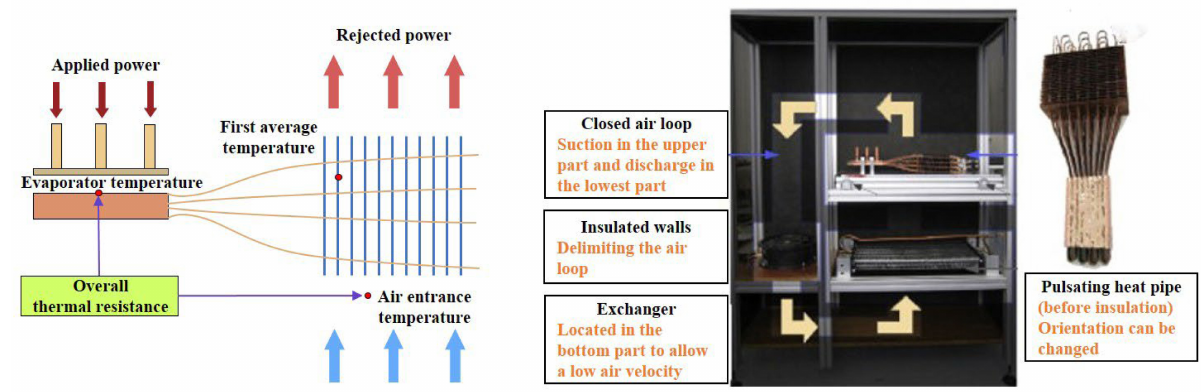
Figure 14. Schematic of the PHP for HEVs and the experimental apparatus loop